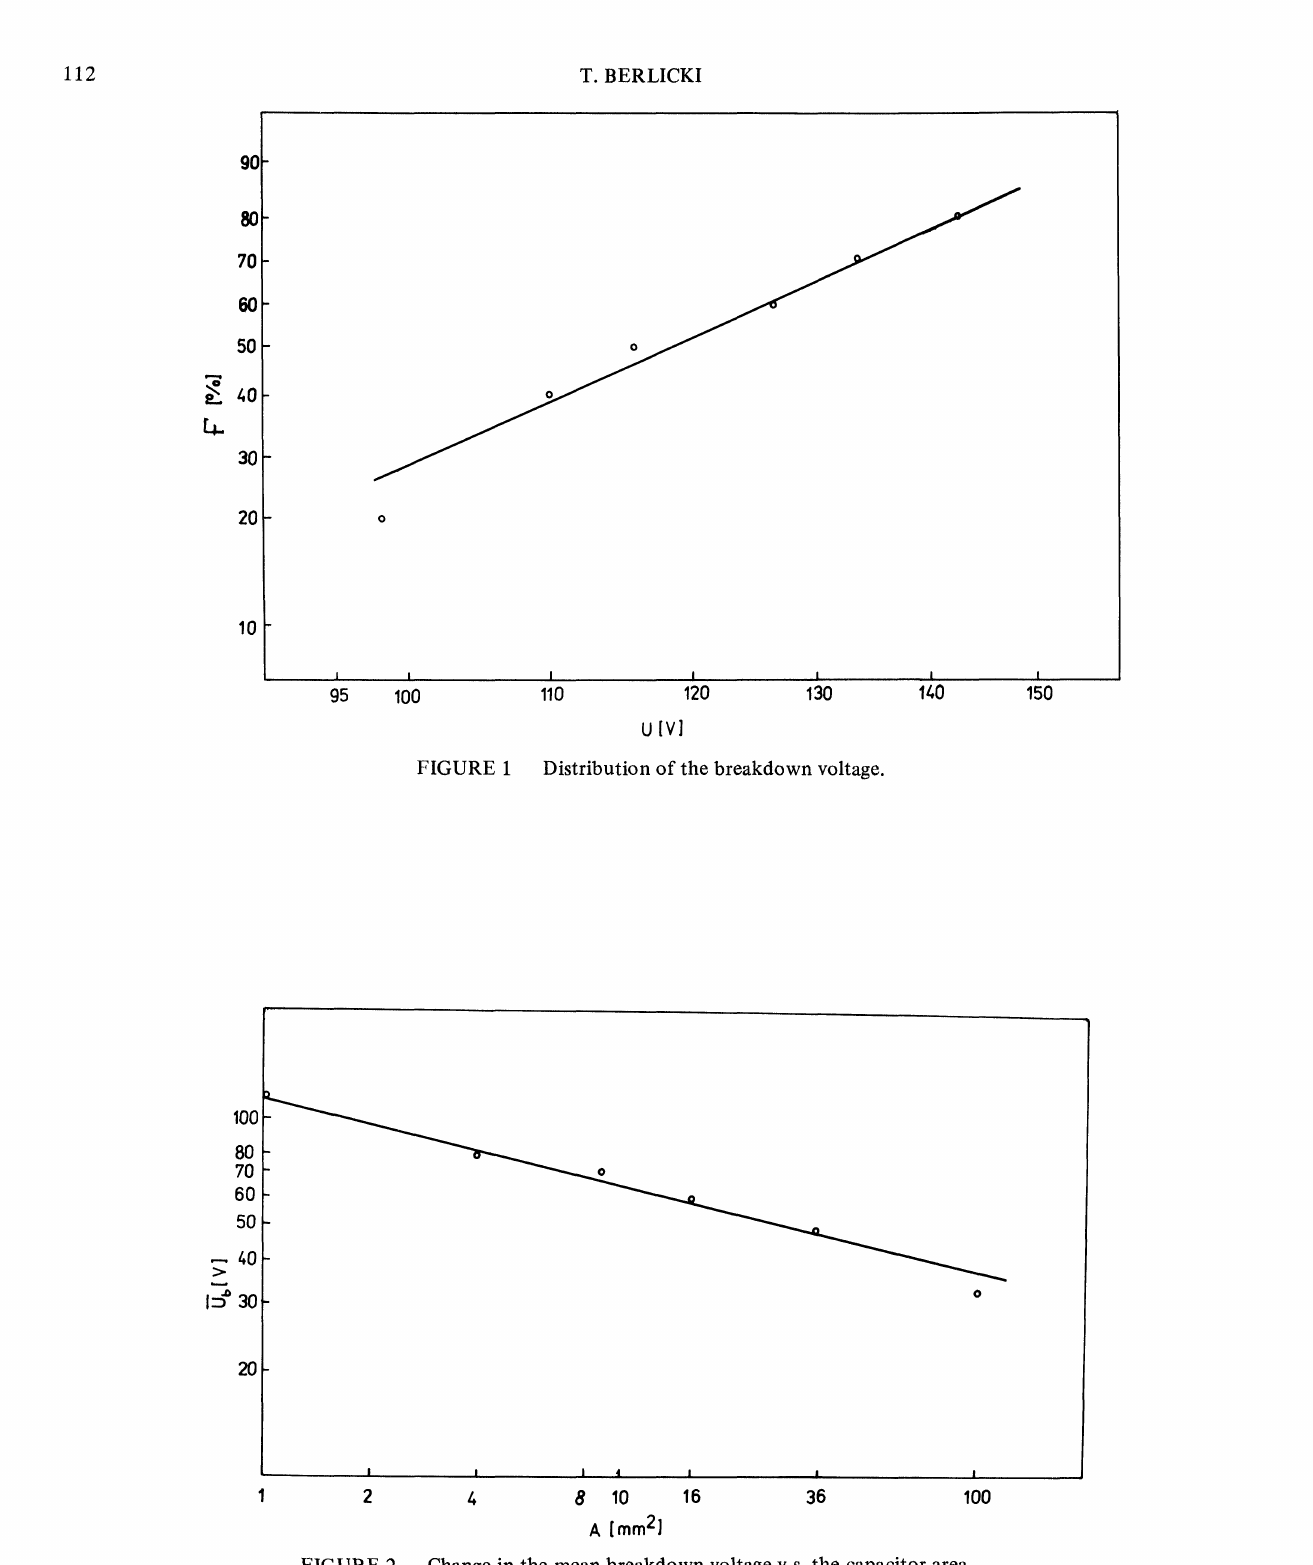
FIGURE 2 Change in the mean breakdown voltage v.s. the capacitor